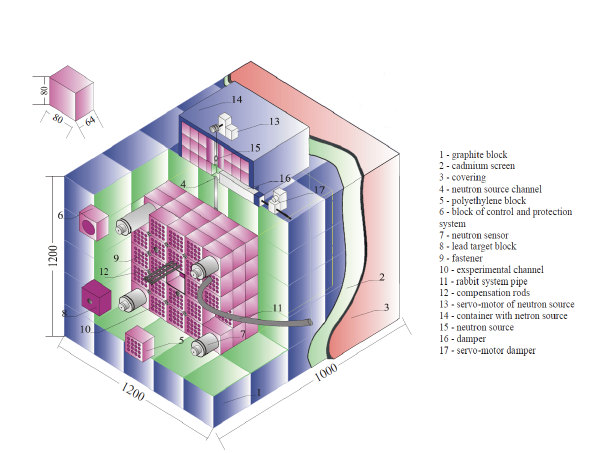
Figure 1: Yalina-Thermal 3D-view blueprint [9]